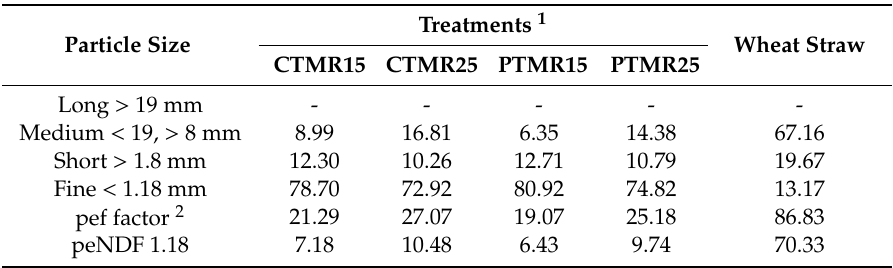
Table 2. Particle size distribution (%) of the experimental diets on a Penn State Particle Separator sieve (long > 19 mm, medium < 19, > 8 mm, short > 1.18 mm), and fine ( < 1.18 mm) fed to male fattening